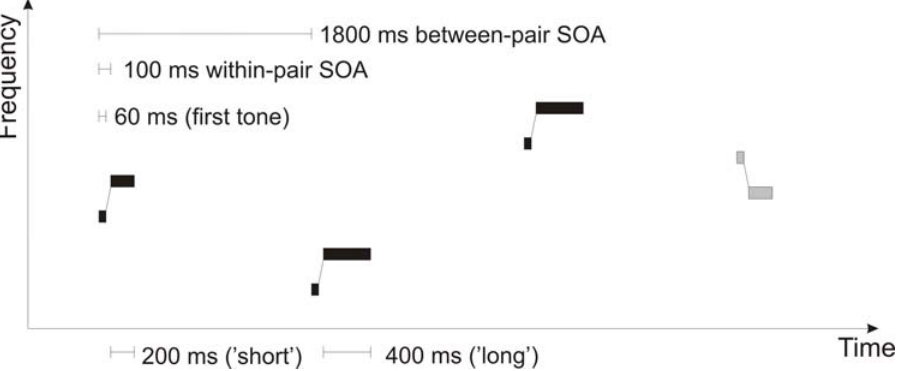
Figure 4. Stimulation for an abstract rule sequence. Tone pairs vary in their absolute frequencies. Standard tone pairs (black) are characterized by an ascending frequency relation, whereas deviant tone pairs (gray) are descending. Duration of the second tone in the pair varies randomly and independently of the frequency relations.